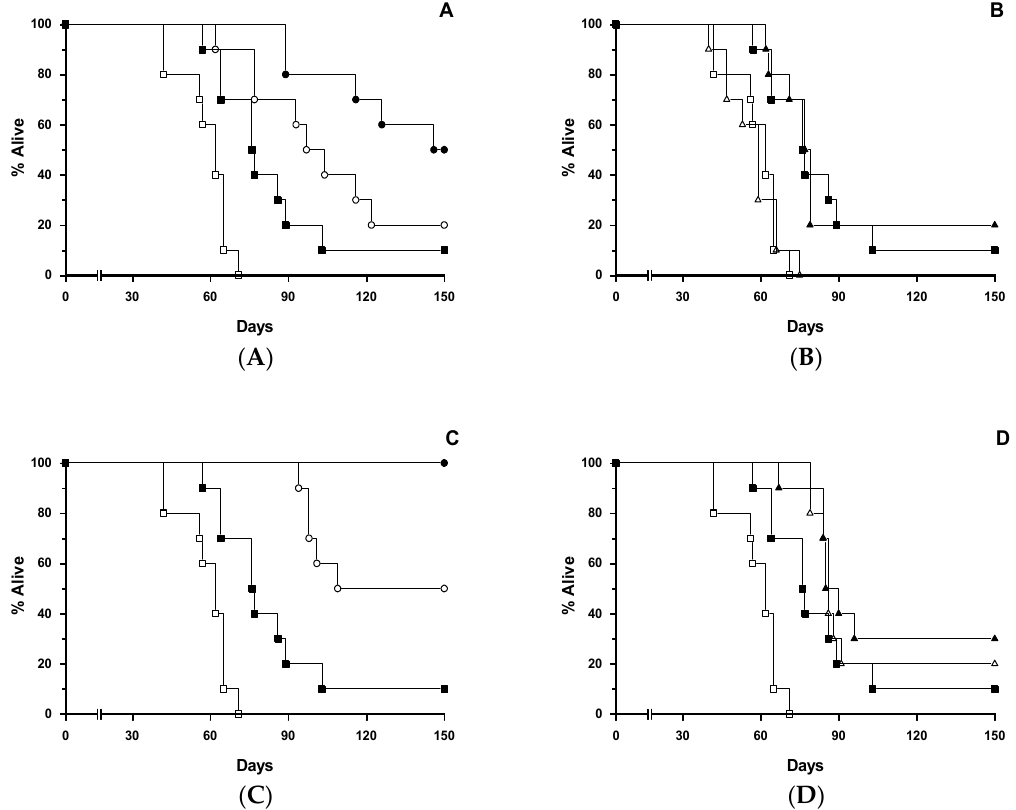
Figure 6. Kaplan-Meier survival curves for SCID-HSB-2 mice receiving a single bolus i.v. injection of phosphate buffered saline (PBS) (open symbols) or a single i.v. bolus injection of [poly(I:C)] (closed symbols) 24 h in advance of treatment with ( A ) intact HB2 antibody ( , ) or PBS ( , ), ( B ) a F(ab’) 2 fragment of HB2 antibody ( , ) or PBS ( , ), ( C ) HB2-SAP IT ( , ) or PBS ( , ), and ( d ) HB2-